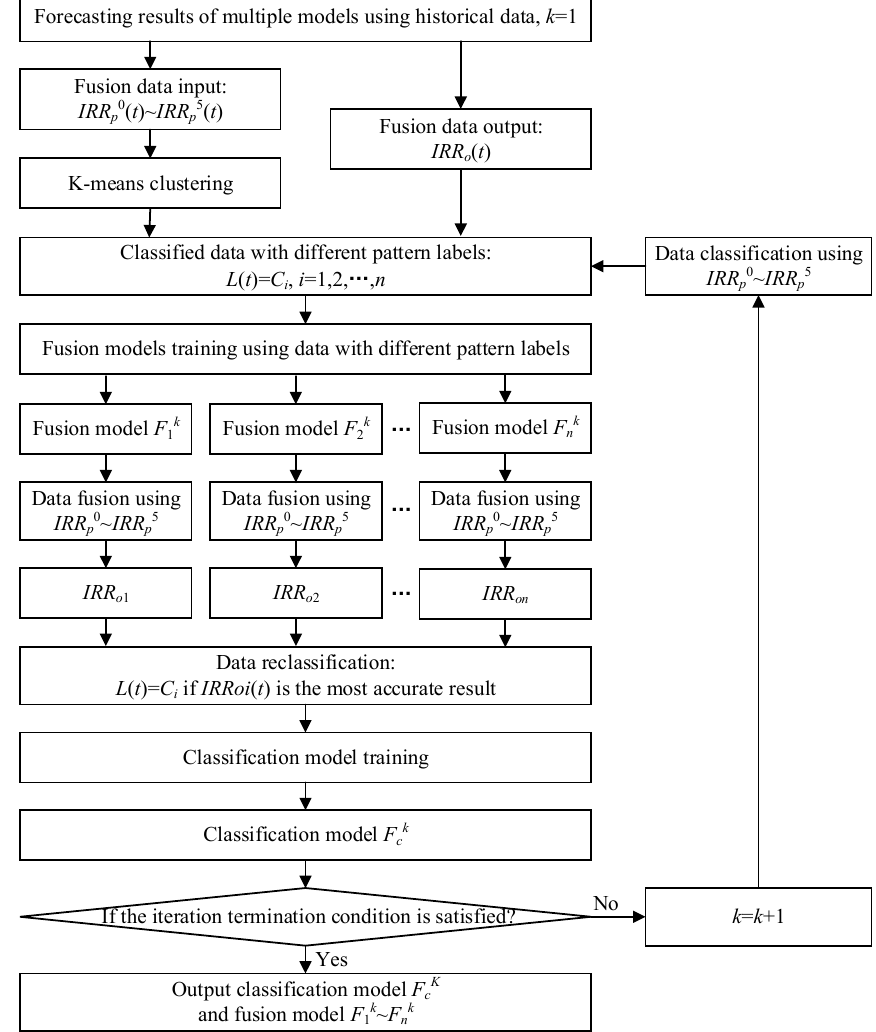
Figure 6. The framework of mutual optimization for pattern classification and data fusion models.